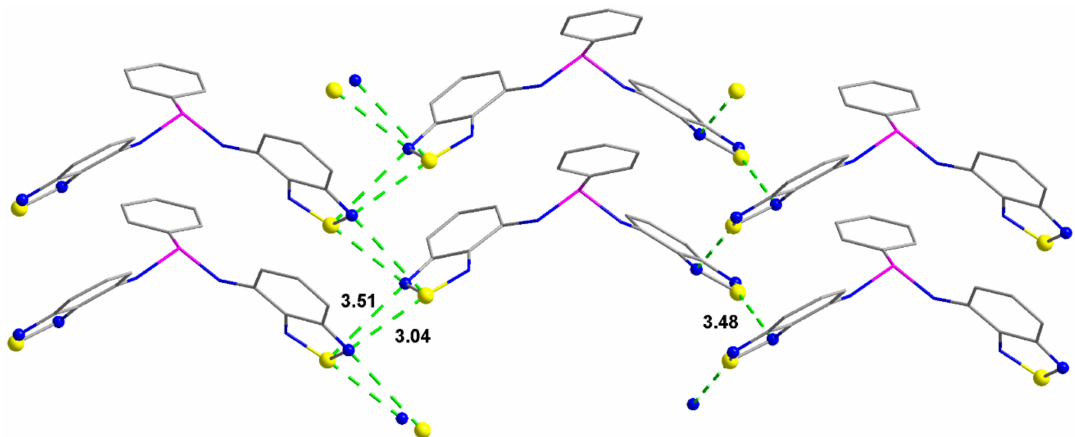
Figure 3. N ··· S intermolecular contacts in H 2 L (“ball and stick” model for atoms participating in the contacts and “wires and sticks” one for others) marked dashed green. Hydrogens are omitted.